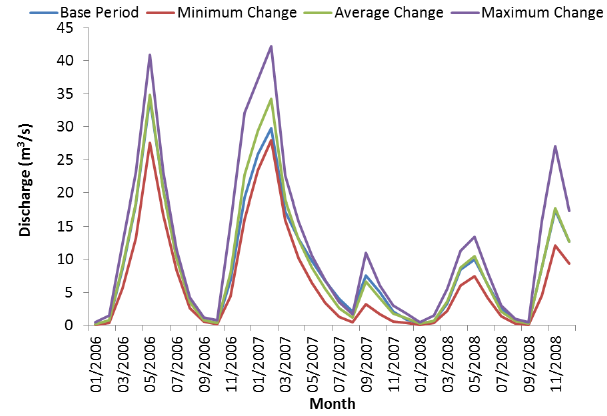
Fig. 9. Nyangores monthly discharge for base period (2006–2008) Figure 9. Nyangores monthly discharge for base period (2006-2008) and climate change scenarios. Different scenarios are described in Table 6. and climate change scenarios. Different scenarios are described